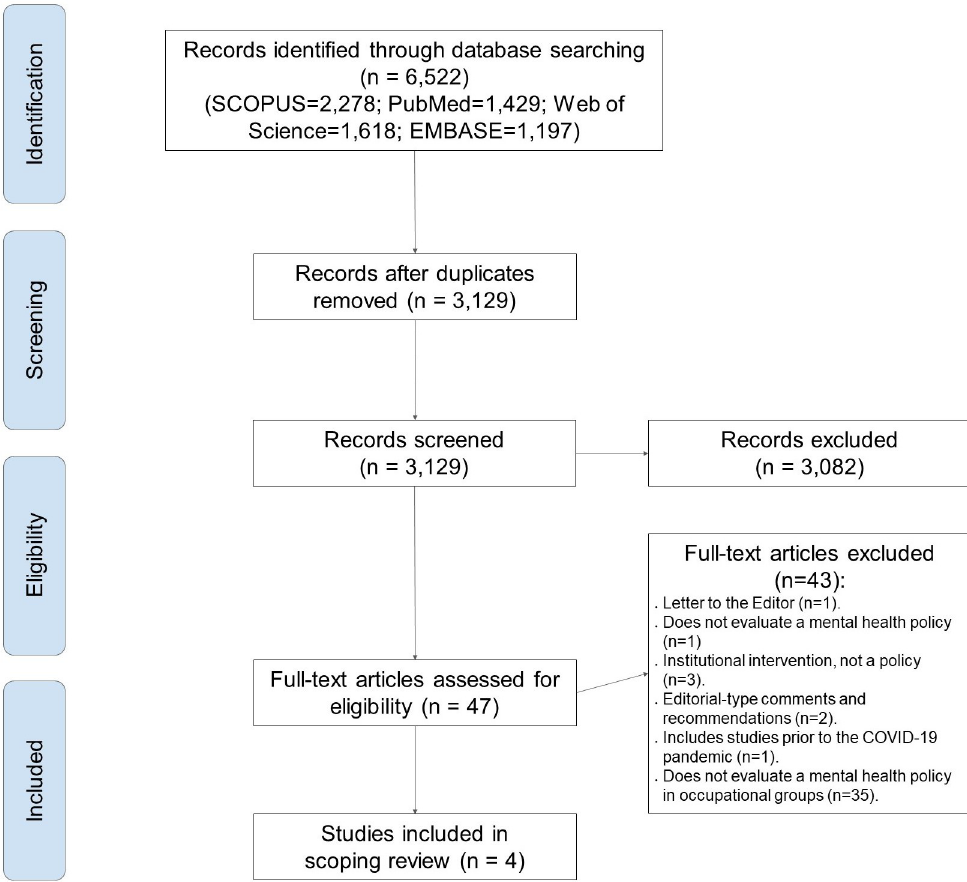
Fig 1. Flowchart according to